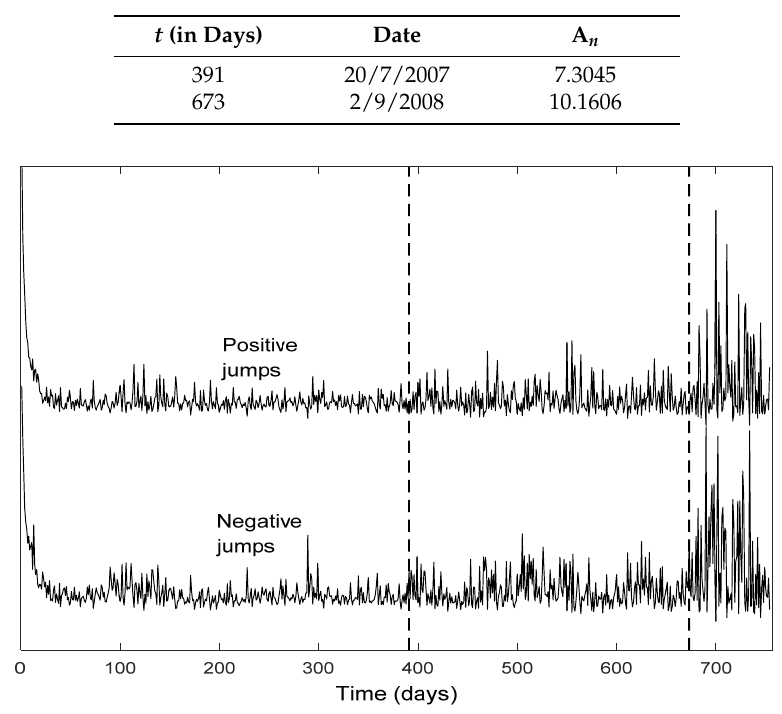
Table 4. Change points in the estimated bivariate jump time series for NASDAQ index with the corresponding test statistic value.